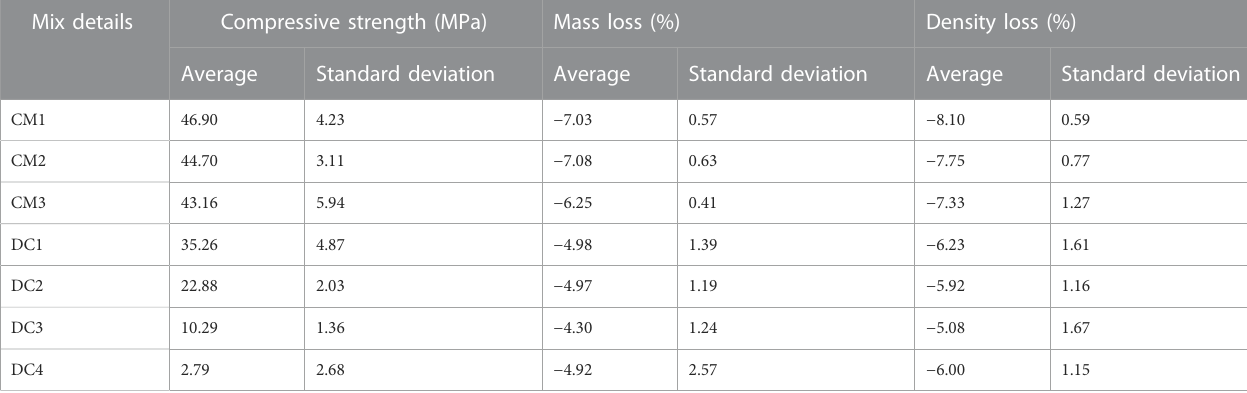
TABLE 4 Summary of test results with standard